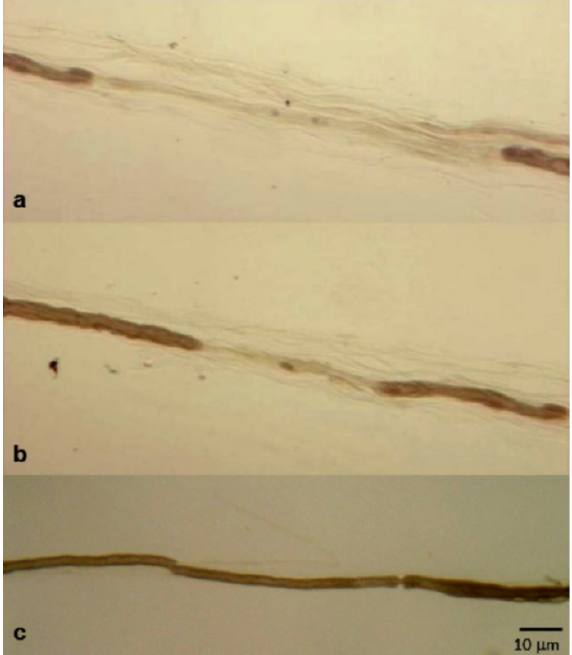
Figure 5. Teased fibers analysis from sural nerve biopsy performed in a 65-year-old man with “atypical” CIDP (multifocal acquired demyelinating sensory and motor neuropathy (MADSAM)) ( a , b ) and from sural nerve biopsy performed in an age-matched control with an axonal polyneuropathy ( c ). Segmental demyelination, found in about 40% of fibers, is shown (a,b). Electron microscopy confirmed the alterations seen on light microscopy and in some cases showed macrophages loaded with myelin debris invading the basal lamina of myelinated fibers (Figure 6a–d).